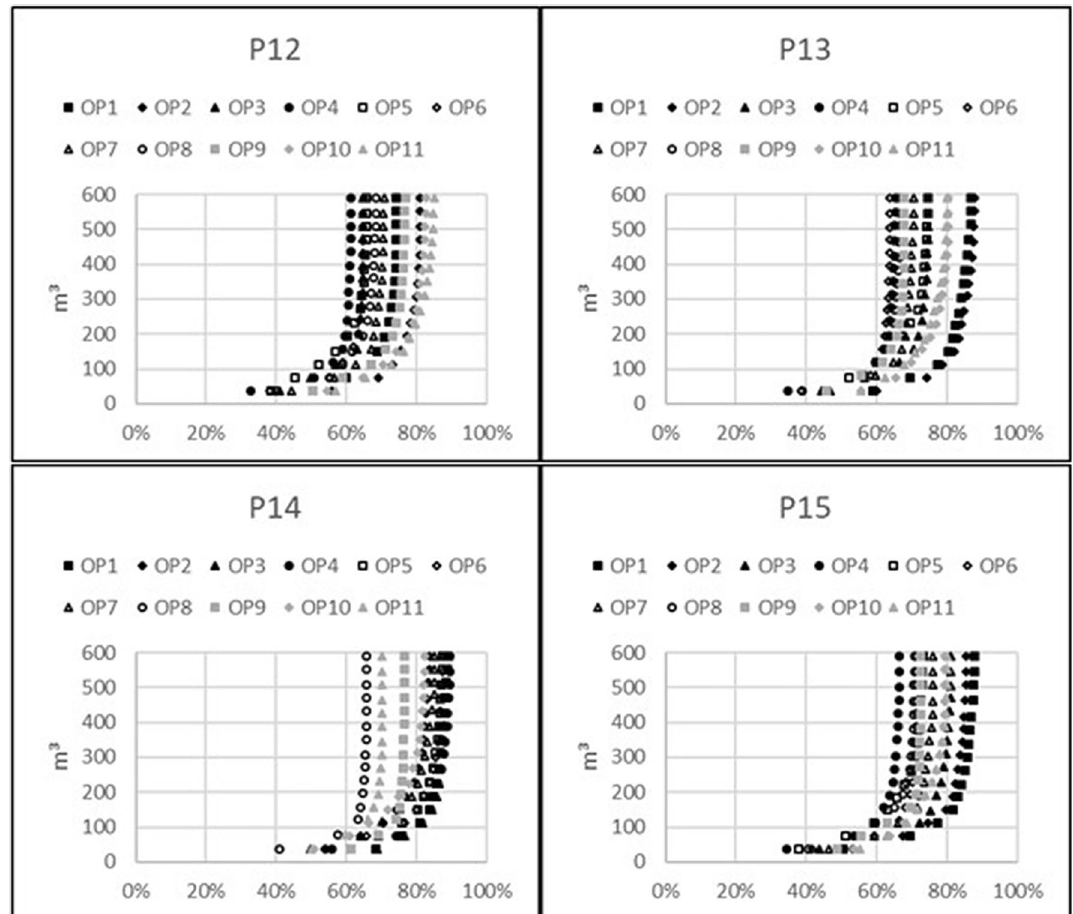
Figure 2. Volume of generated waste caused by topsoil removal with regard to relative dose reduction for 11 observation points inside a wooden house on properties P12–P15.